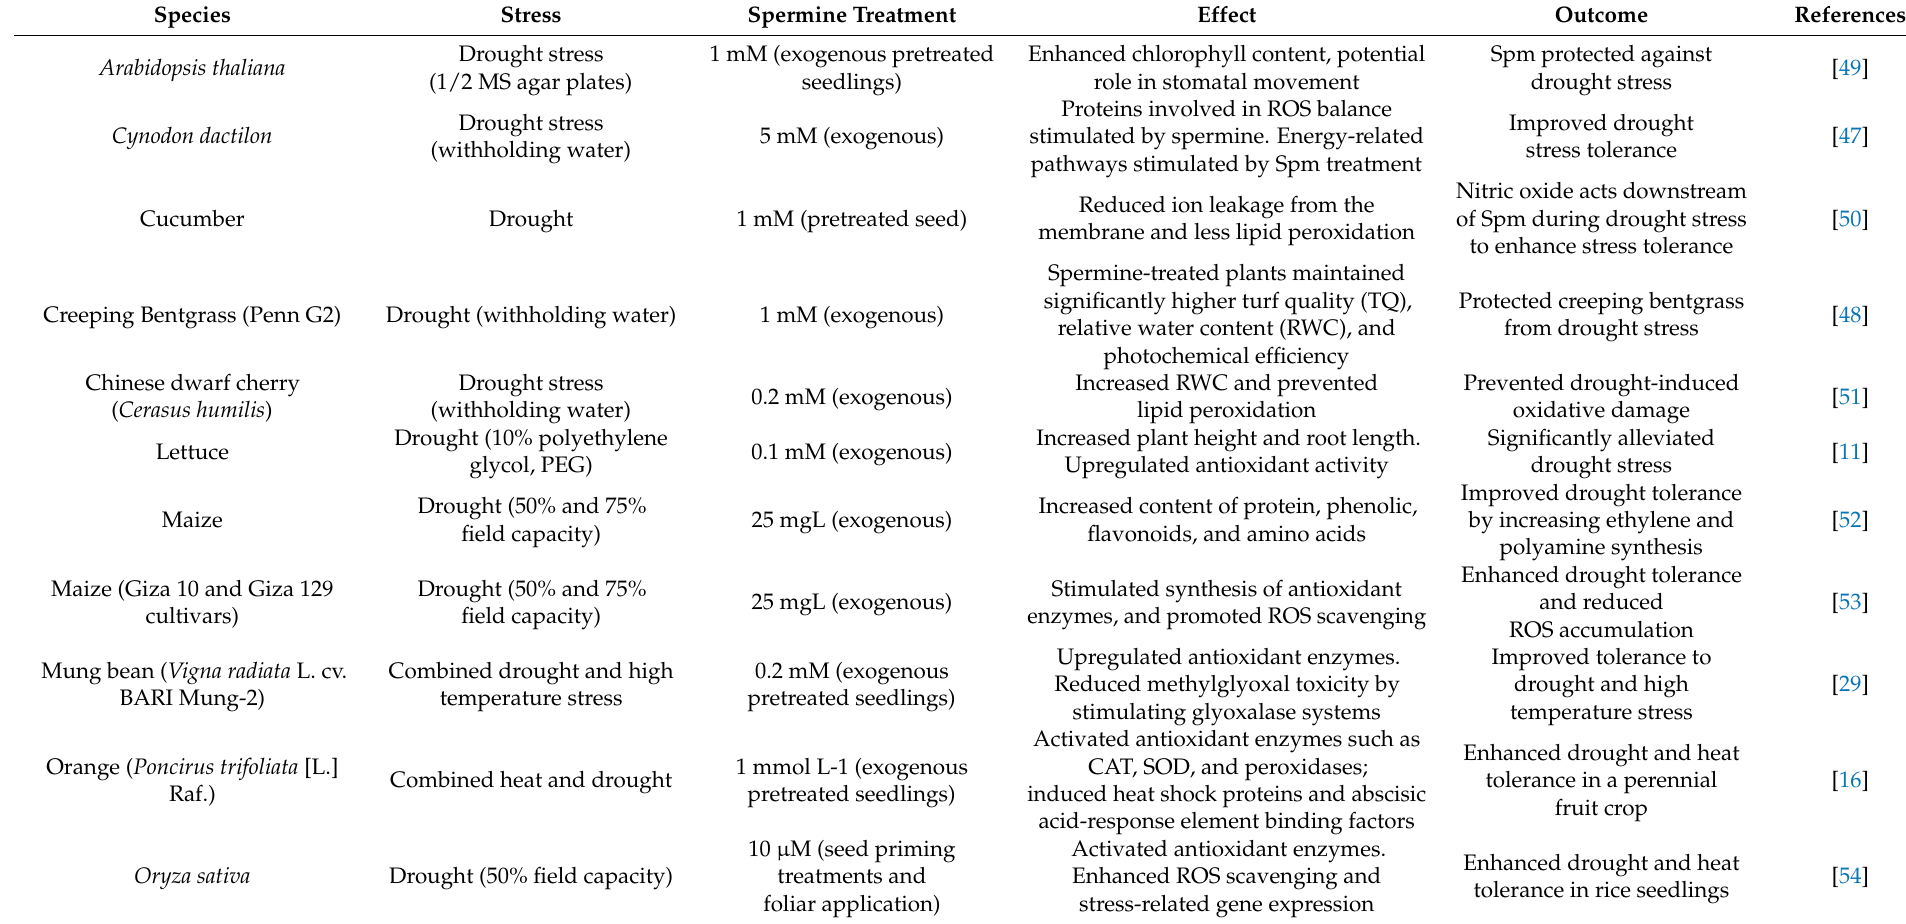
Table 1. Spermine mediated growth, improved photosynthetic parameters and osmoregulation, and enhanced antioxidant defense in different plant species under drought stress.